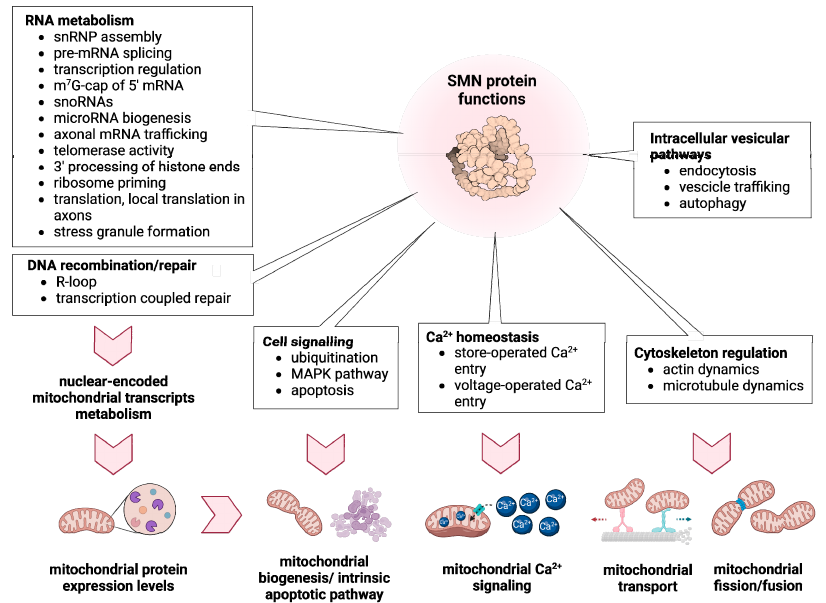
Figure 2. Schematic summary of the known functions of SMN and their impact on mitochondrial homeostasis. As crucial regulator of RNA metabolism and DNA recombination/repair, SMN mod- ulates the expression levels of many mitochondrial proteins that are essential for mitochondrial ho- meostasis (biogenesis, apoptosis induction, Ca 2+ signaling, transport and dynamics). By interacting with a plethora of proteins, SMN is also involved in different cell signaling pathways and in the dynamic regulation of membranes and cytoskeleton. All these SMN functions are ultimately crucial for mitochondrial biogenesis, Ca 2+ signaling, transport and dynamics. The figure was created with BioReneder.com. Rarely, some individuals—most often siblings of SMA patients or parents of SMA children—carry homozygous SMN1 deletions and identical SMN2 copies as the affected sibling(s) but do not exhibit SMA symptoms, strongly indicating protection via SMA mod- ifying gene (s). In humans, two protective modifiers/cellular processes have been reported so far: upregulation of plastin 3 (PLS3) and downregulation of neurocalcin delta (NCALD)